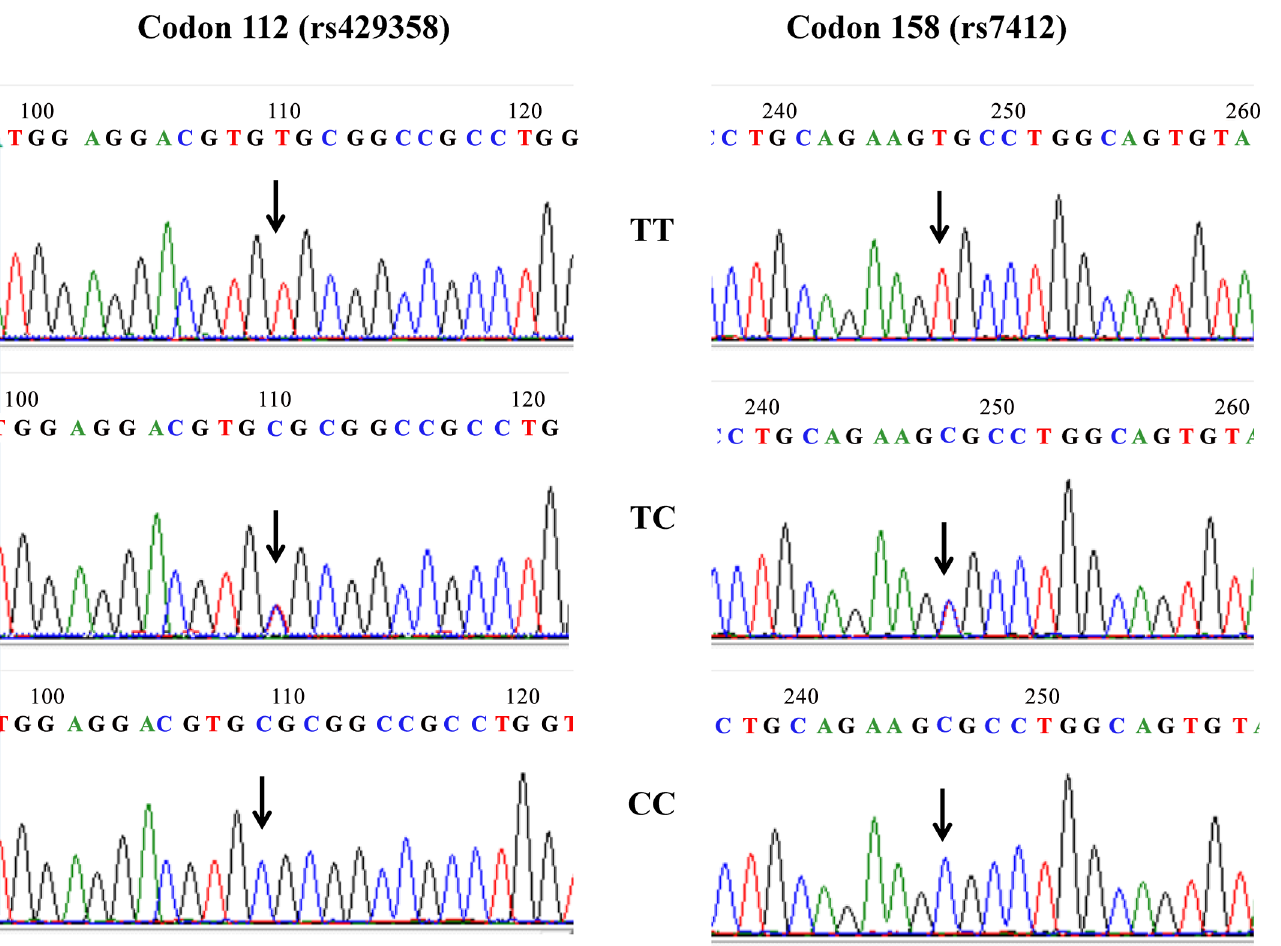
Fig 2. Traces of Sanger sequencing of APOE genotyping of codon 112 (rs429358) and codon 158 (rs7412). TT indicates homozygote of TT; TC indicates TC heterozygote, and CC indicates homozygote of CC. The arrow indicates the position of the single nucleotide polymorphism.